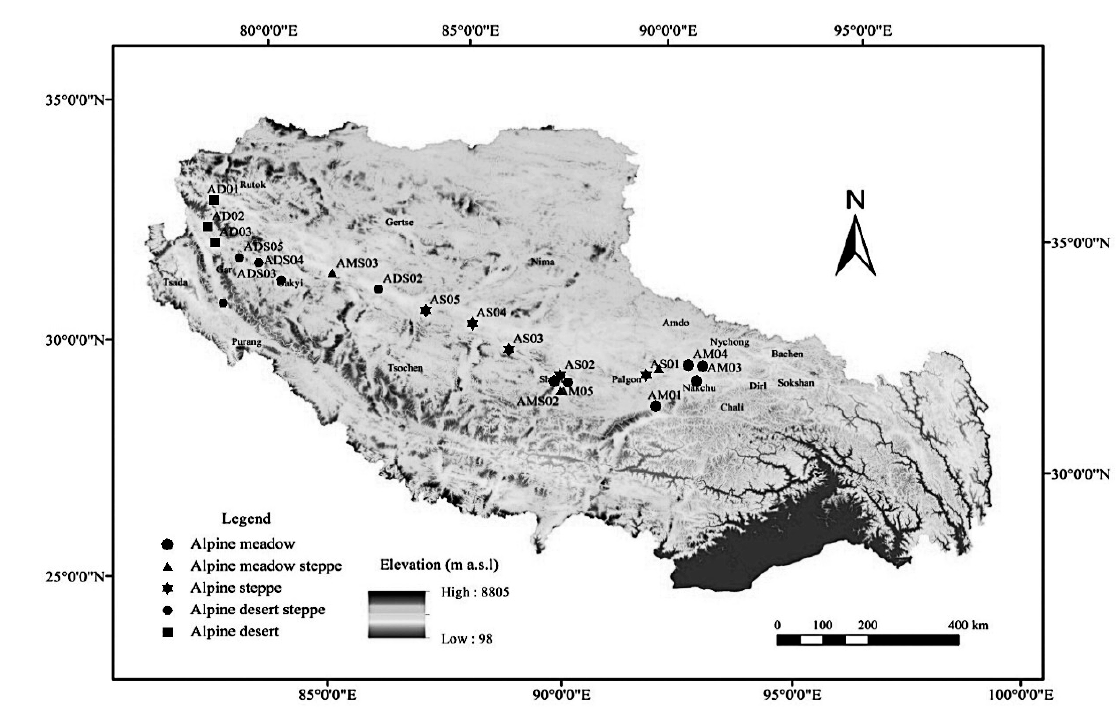
Figure 1. Research areas and sampling sites. Table 1. Sample geographical locations and other information of the five alpine